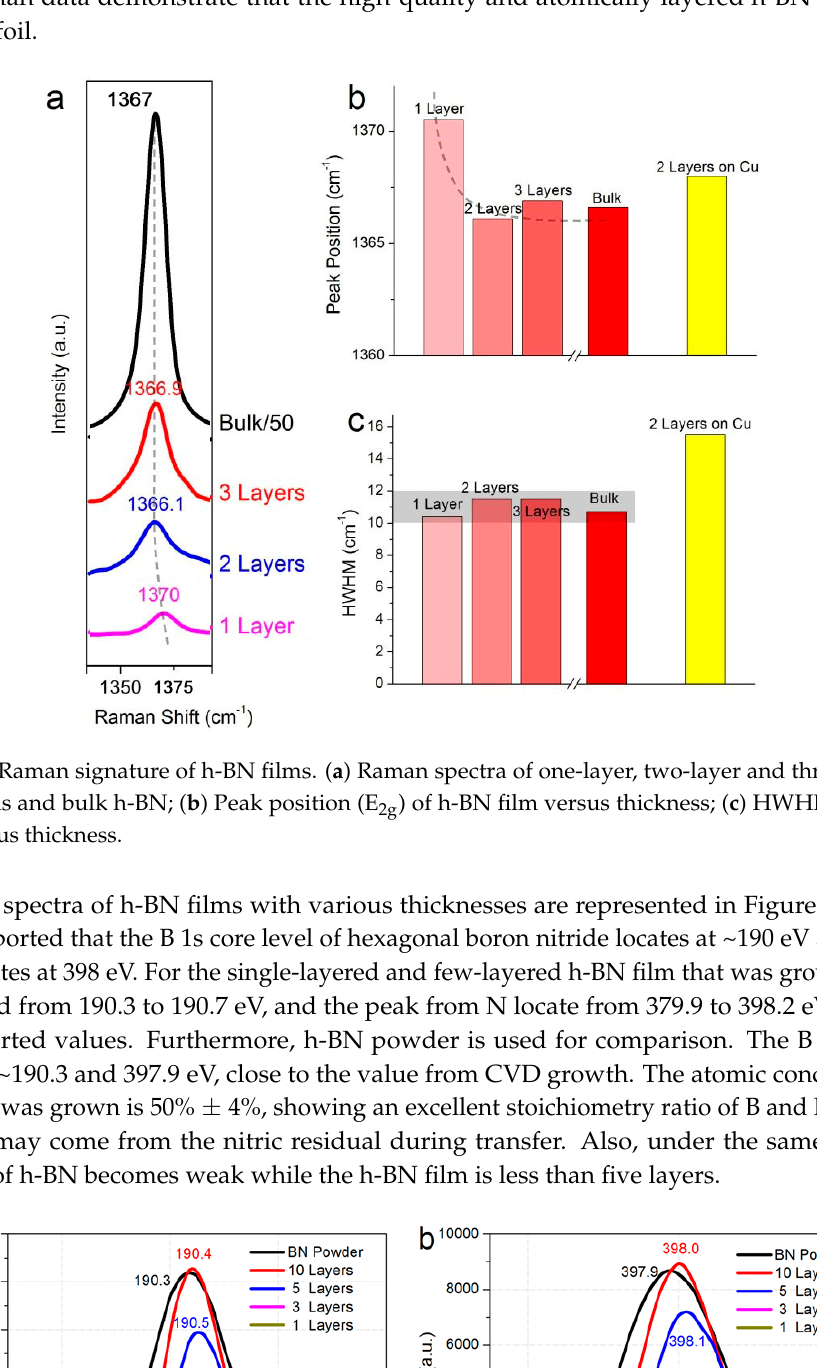
Figure 5. XPS signature of h-BN films. ( a , b ) XPS spectra of B and N 1s core level of samples in various thicknesses.